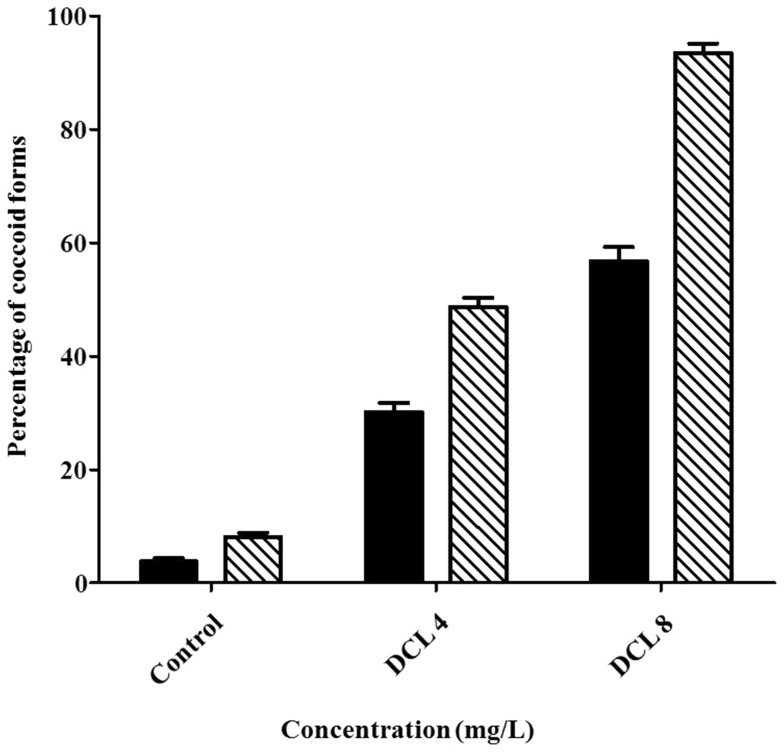
The proportion of coccoid versus spiral form.
H. pylori ATCC43504 was cultured in Brucella broth without or with dehydrocostus lactone (DCL) at 1 (4 mg/L) and 2 times (8 mg/L) the minimal inhibitory concentration for 24 (▪) and 48 h (□). Effect of concentration (F = 1363.16; df  = 2, 15; P<0.0001) and exposure time (F = 188.66; df  = 1, 15; P<0.0001) on conversion of H. pylori to the coccoid form was significant when H. pylori controls were compared to DCL-treared H. pylori. The concentration by exposure interaction was also significant (F = 40.41; df  = 2, 15; P<0.0001). DCL caused considerable conversion to the coccoid form (58 versus 30% at 8 and 4 mg/L DCL for 24 h; 94 versus 49% at 8 and 4 mg/L DCL for 48 h).